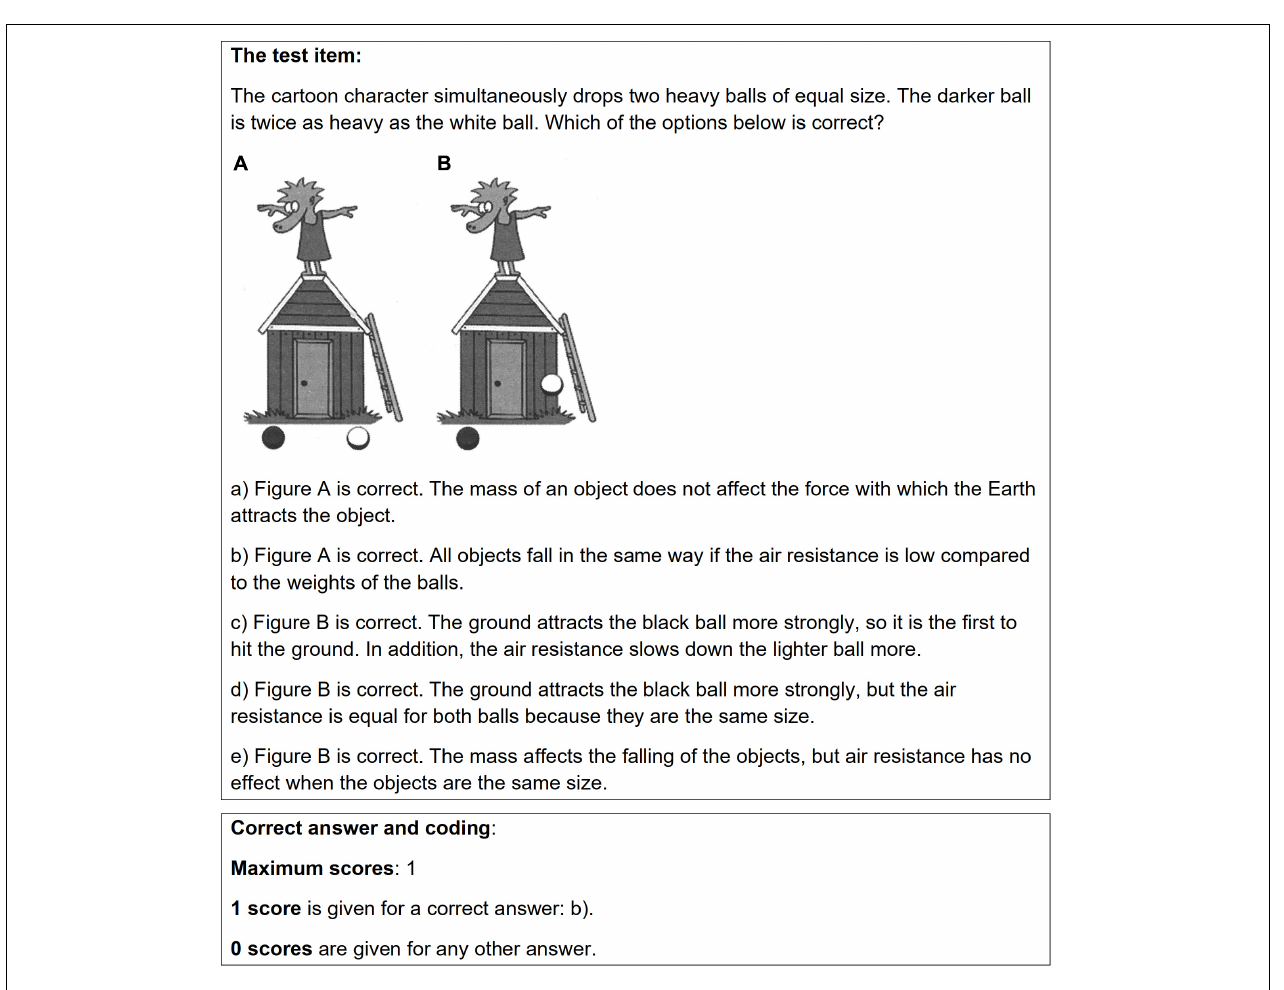
FIGURE 2 | An example of a multiple-choice test item focusing on disciplinary core ideas (gravitational